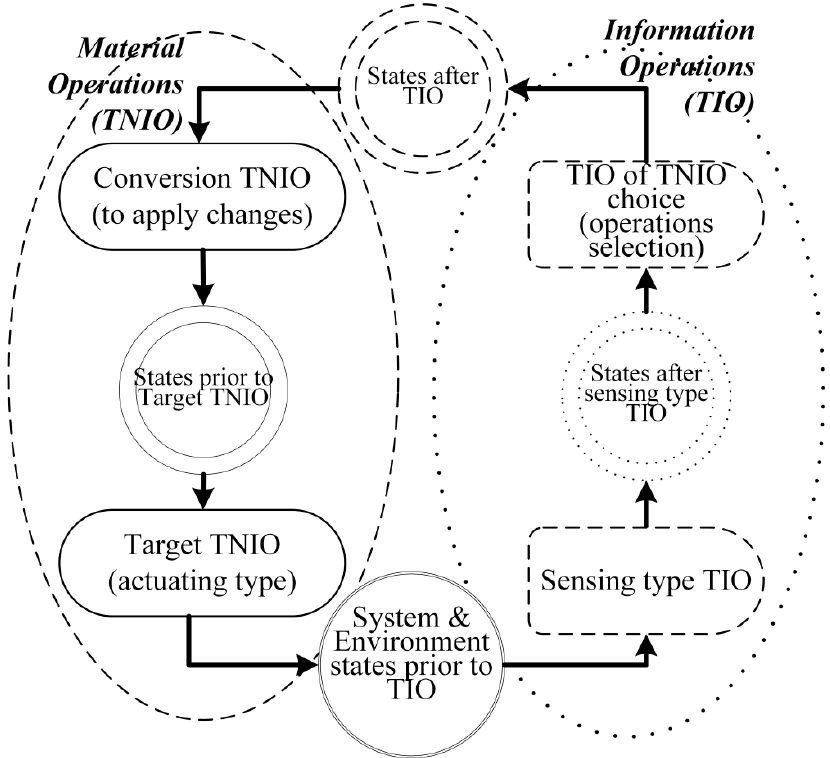
Figure 1. A loop of technological information operations and caused by them material (non information) operations used during system functioning. TIO: technological information operations; TNIO: technological non-information operations.